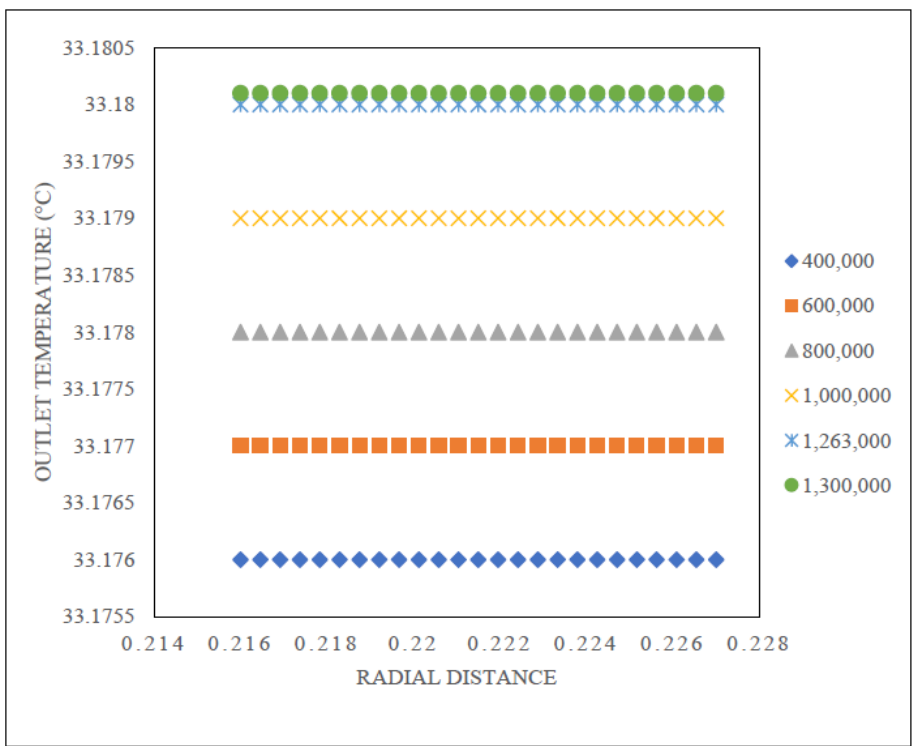
Figure 6. Validation of various models.